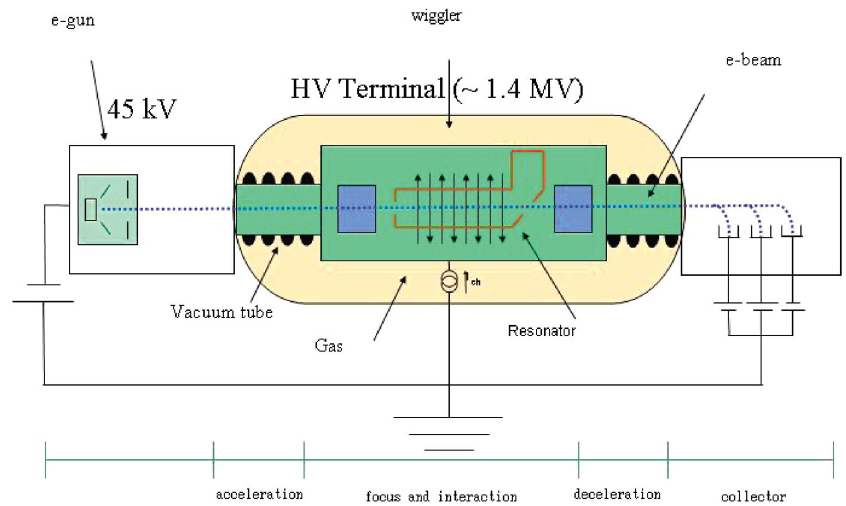
FIG. 1. (Color) Schematic drawing of the Israeli Electrostatic-Accelerator FEL